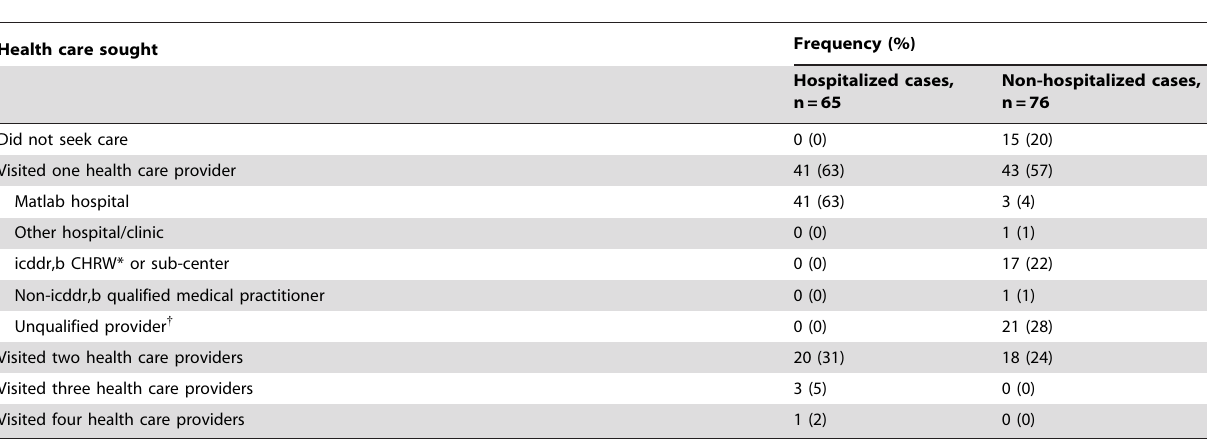
Table 5. Health care seeking pattern of hospitalized and non-hospitalized children aged , 5 years with severe acute respiratory infections in Matlab, Bangladesh, June–October